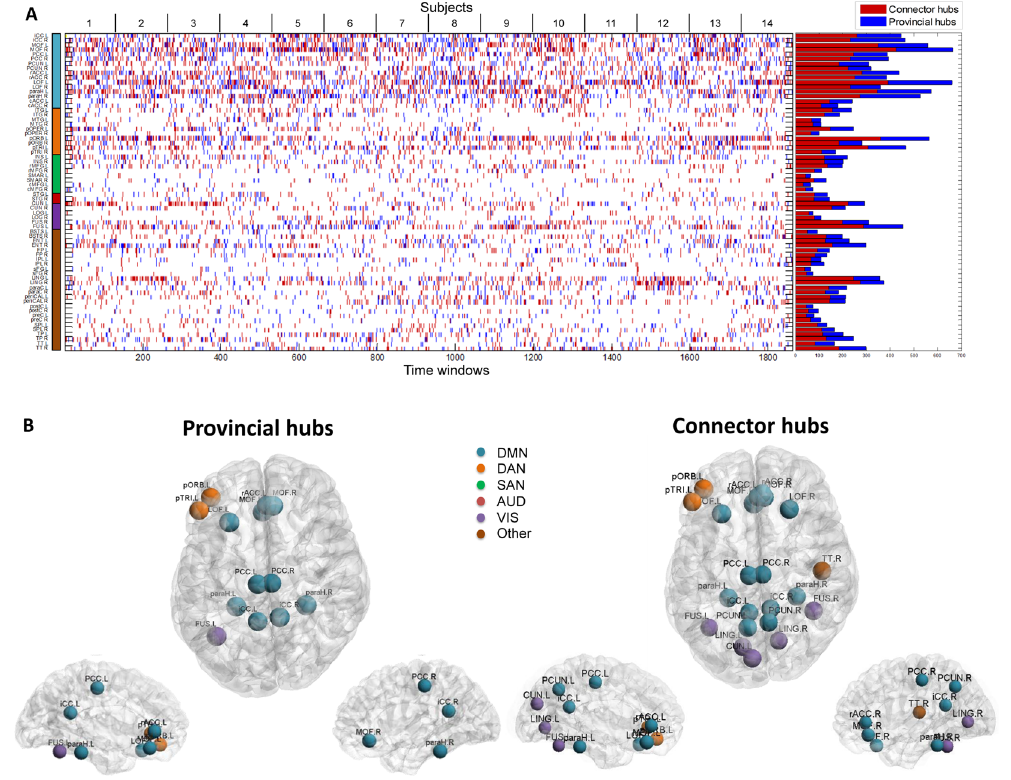
Figure 6. Dynamic analysis: modularity. ( A ) left : The variations of the node’s type (provincial vs. connector) across time for each of the 68 brain regions, right : The bar plots represent the number of times a node is considered as provincial hub (blue color) and as connector hub (red color). ( B ) The spatial distributions of significant provincial hubs, and significant connector hubs. Names and abbreviations of the brain regions are listed in Table